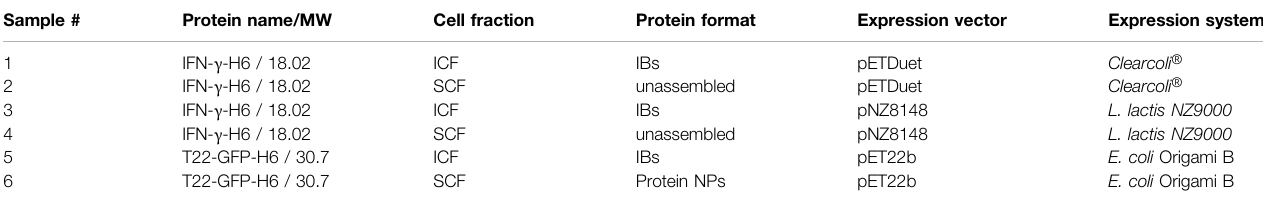
TABLE 1 | Detailed information of the protein name, cell fraction origin, protein format, and expression system of the recombinant proteins used in the study. Sample